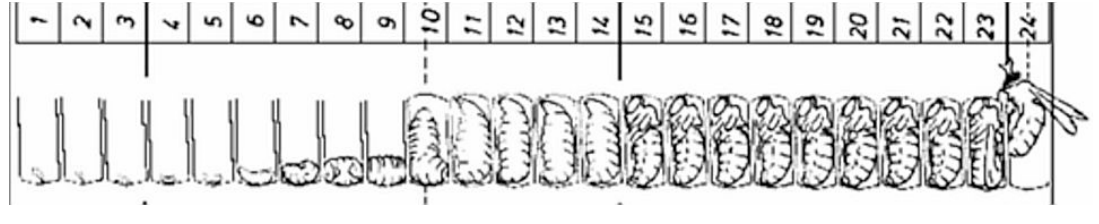
Figure 1. Drone brood development stage [23].